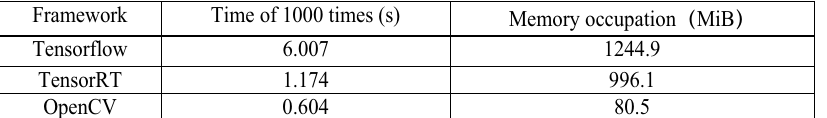
Table 2. (cid:3) Comparison of deployment models of various frameworks. (cid:3)